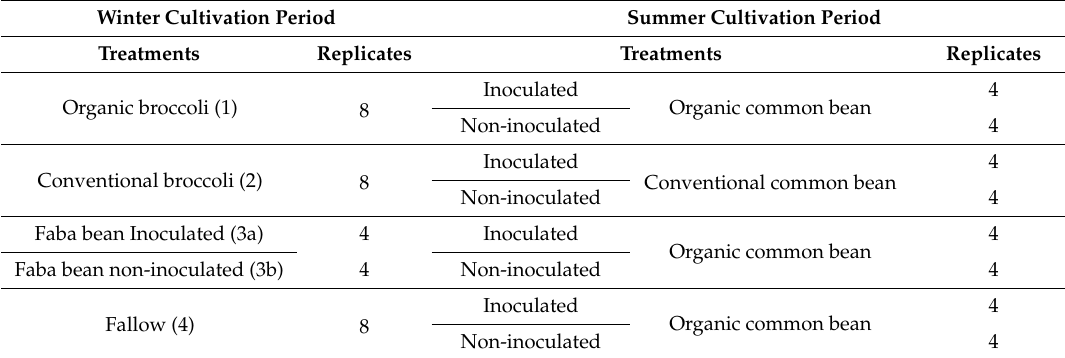
Table 2. An overview of the experimental treatments applied in both experimental years. Winter Cultivation Period Summer Cultivation Period Treatments Replicates Treatments Replicates Inoculated 4 Organic broccoli (1) 8 Organic common bean Non-inoculated 4 Inoculated 4 Conventional broccoli (2) 8 Conventional common bean Non-inoculated 4 Faba bean Inoculated (3a) 4 Inoculated 4 Organic common bean Faba bean non-inoculated (3b) 4 Non-inoculated 4 Inoculated 4 Organic common bean Fallow (4) 8 Non-inoculated